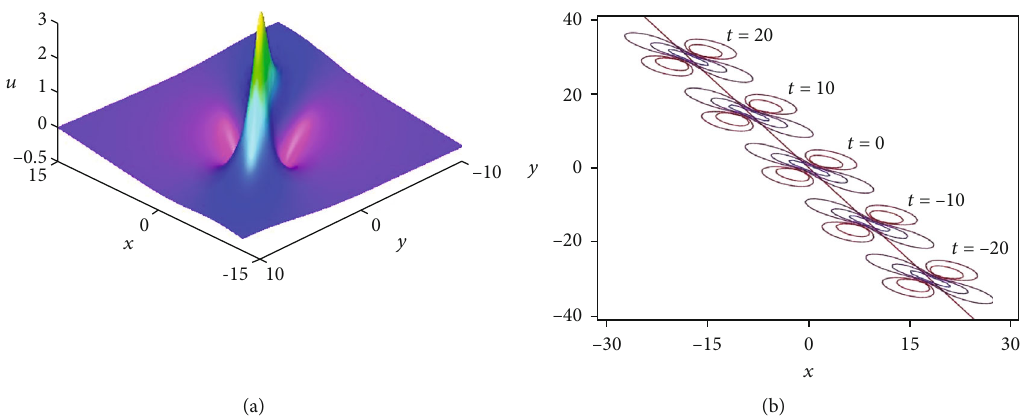
= − 1/5 , a = 2 , and a = a = 0 : (a) the three-dimensional 2 6 4 8